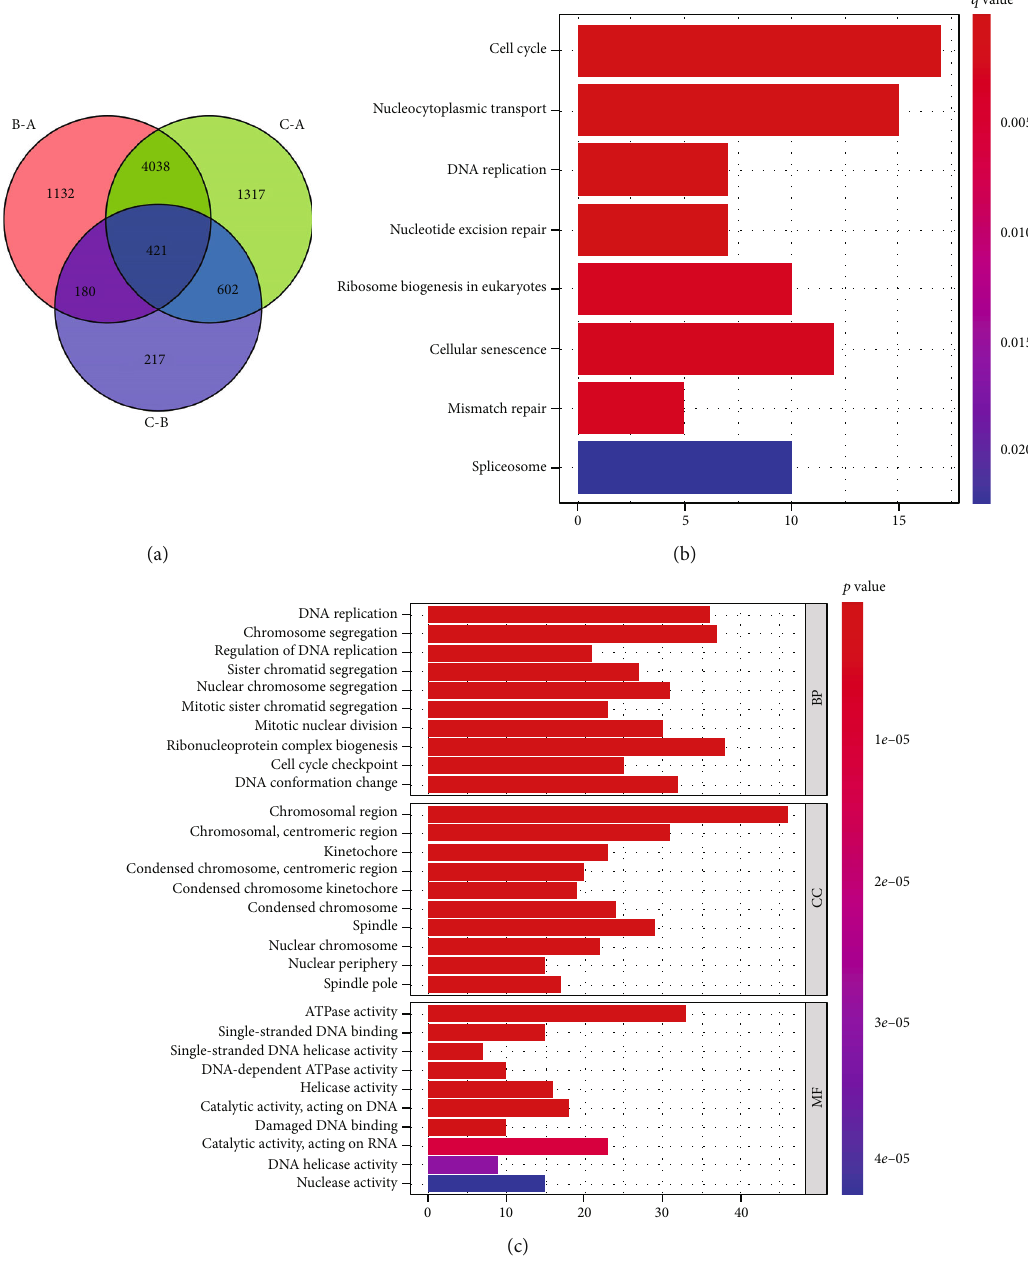
Figure 4: DEG identi fi cation and annotation of functions. (a) The Venn diagram of intersecting genes between CRGs. (b) An examination of the enrichment of DEGs in KEGG pathways. (c) An investigation of the enrichment of GO functions in DEGs. DEGs: di ff erentially expressed genes; CRG: cuproptosis-related